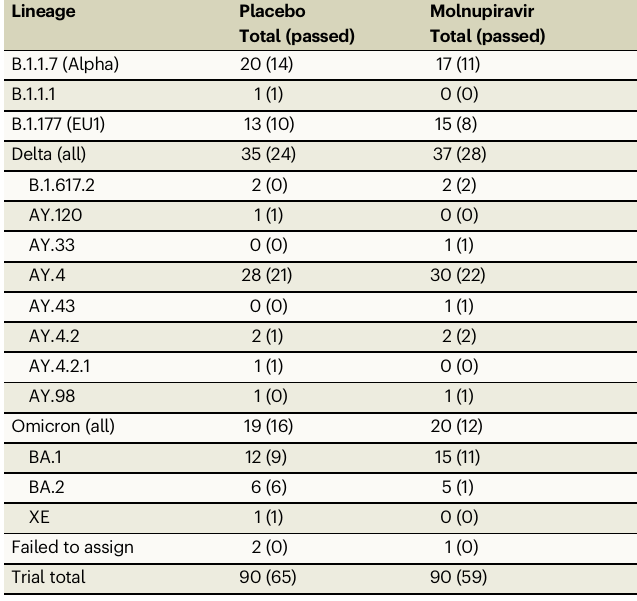
Table 1 | Lineage assignment of SARS-CoV-2 from participants enrolled in the AGILE CST-2 phase IIa molnupiravir clinical